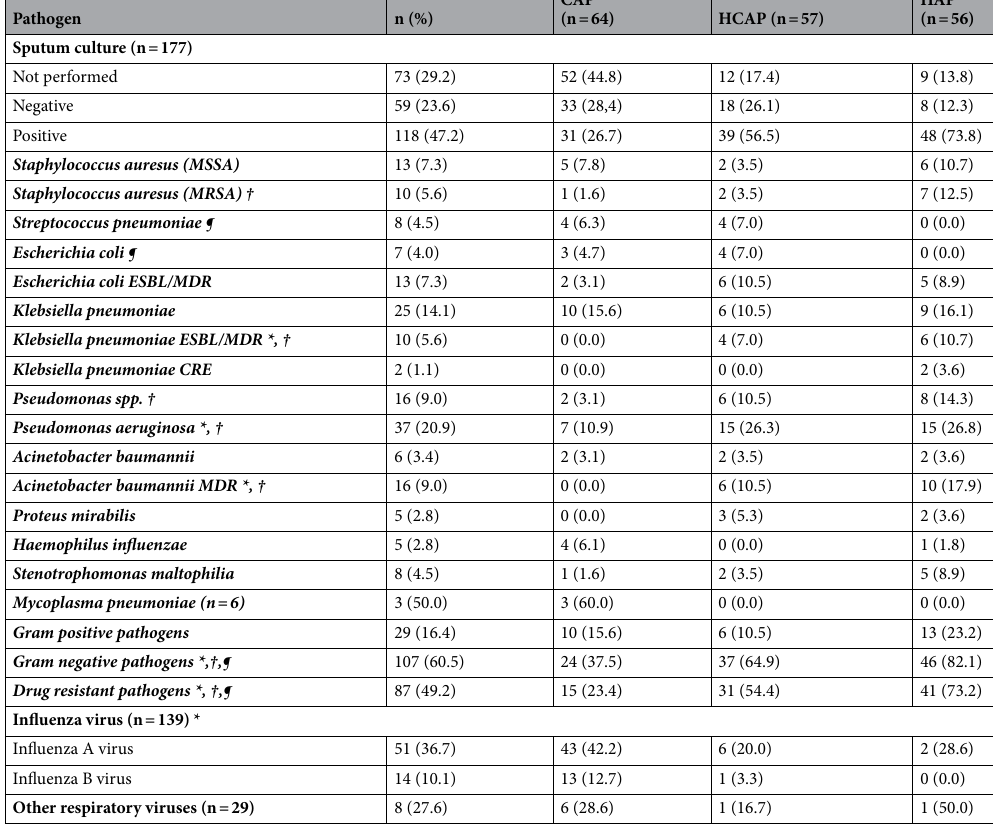
Table 2. Microbiological etiology. CAP; community acquired pneumonia, HCAP; healthcare-associated pneumonia, HAP; hospital-acquired pneumonia, qSOFA; quick sequential organ failure assessment, SD;